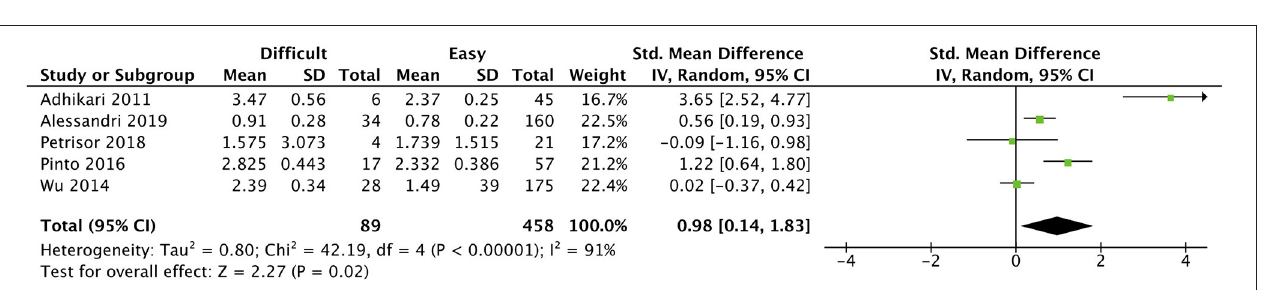
FIGURE 2 | Skin to Hyoid bone distance forest plot comparing difficult and easy laryngoscopy groups.